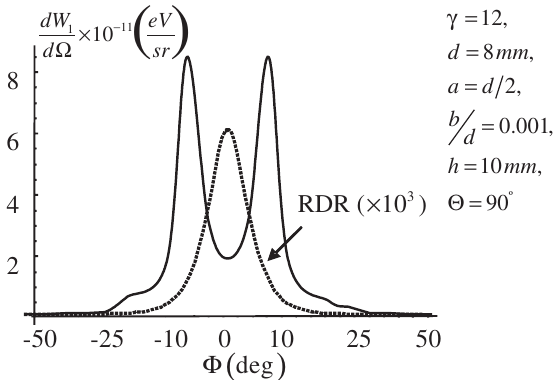
FIG. 11. Azimuth dependence of the SPR intensity for a flat grating according to van den Berg’s model (a solid line) and according to the RDR model (a dotted line, should be multiplied by 10 3 ).